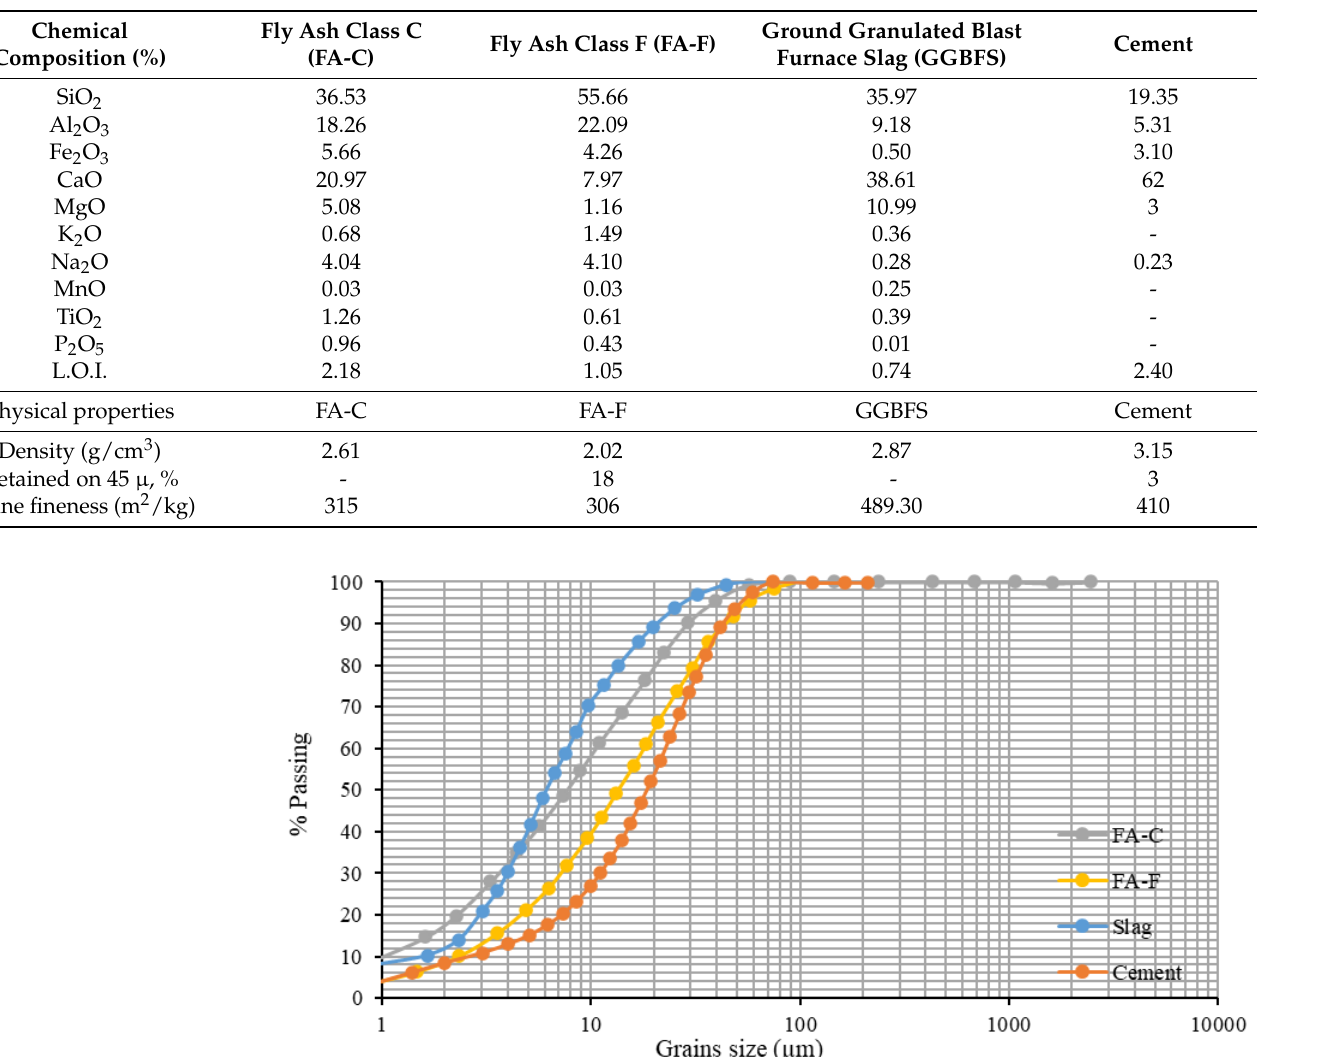
Table 1. Chemical and physical properties of precursors and cement.